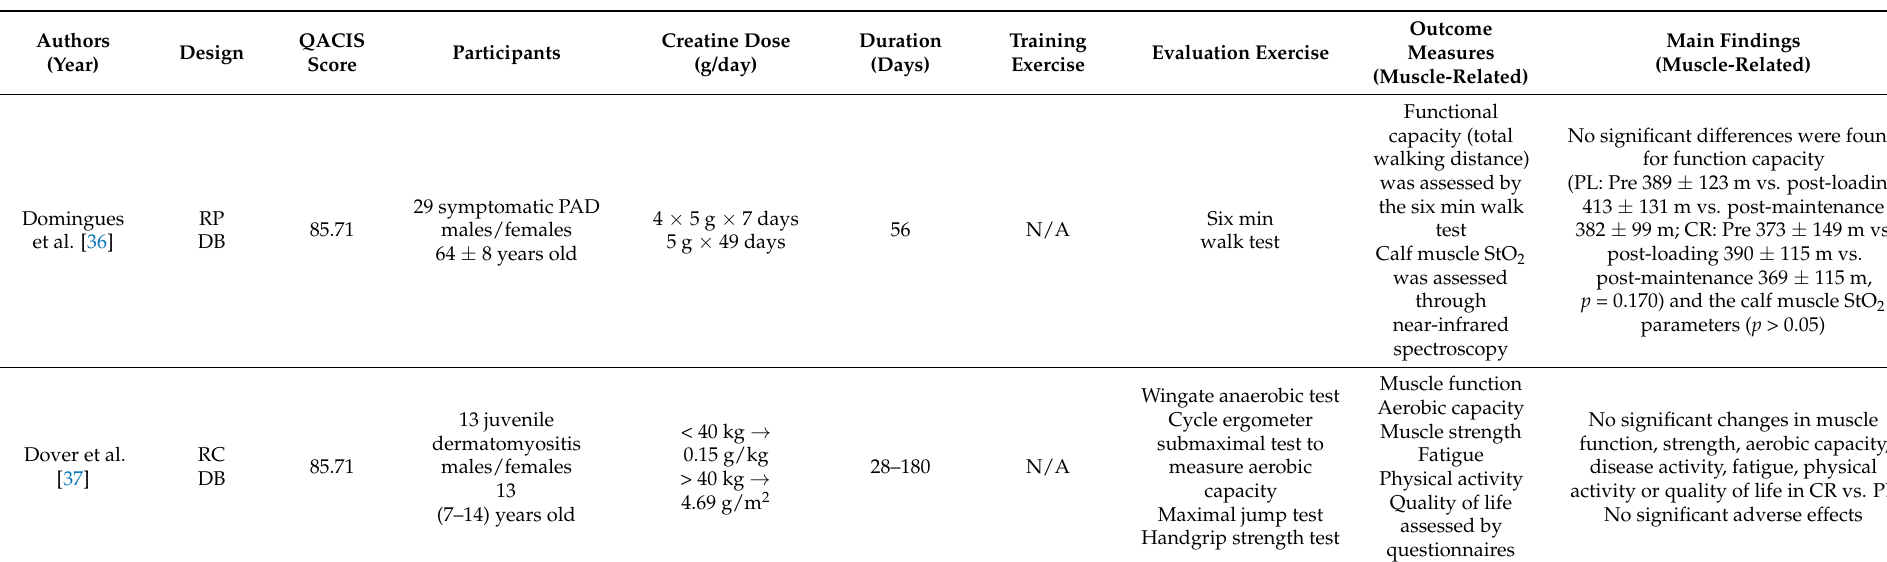
Table 5. Studies recruiting disease-related